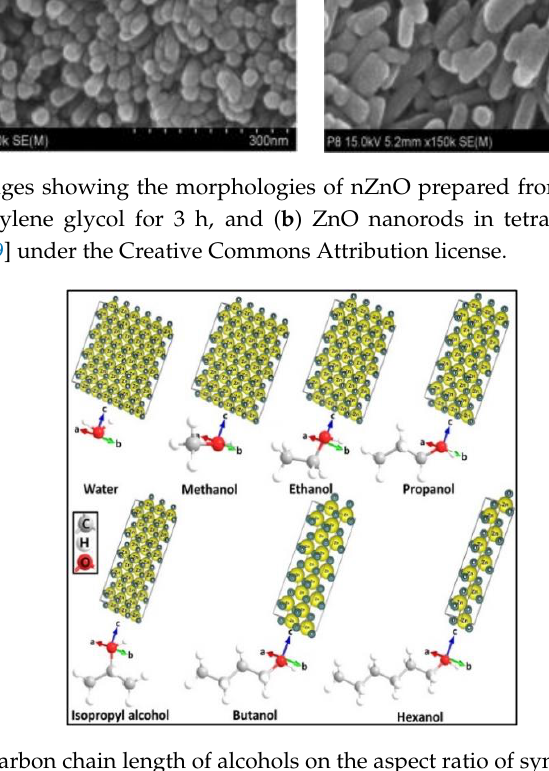
Figure 15. Effect of carbon chain length of alcohols on the aspect ratio of synthesized ZnO nanorods. Reproduced from [108] under the Creative Commons Attribution license.